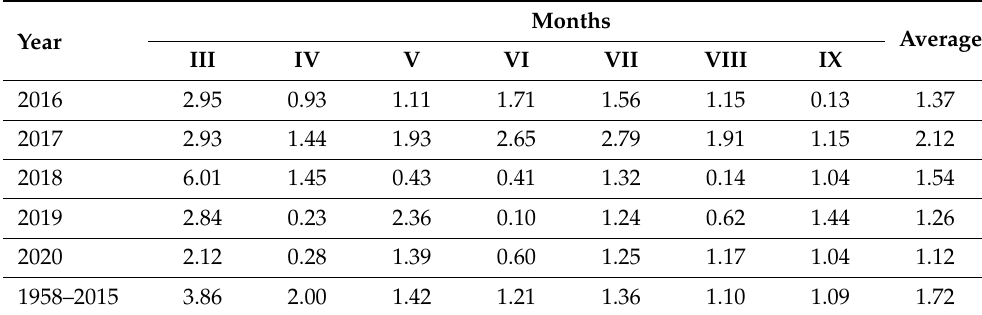
Table 1. Hydrothermal index: Sielianinov index (K) in the growing season (March to September) in 2016–2020 (recorded at the Agrometeorological Observatory in Gorzy´n,